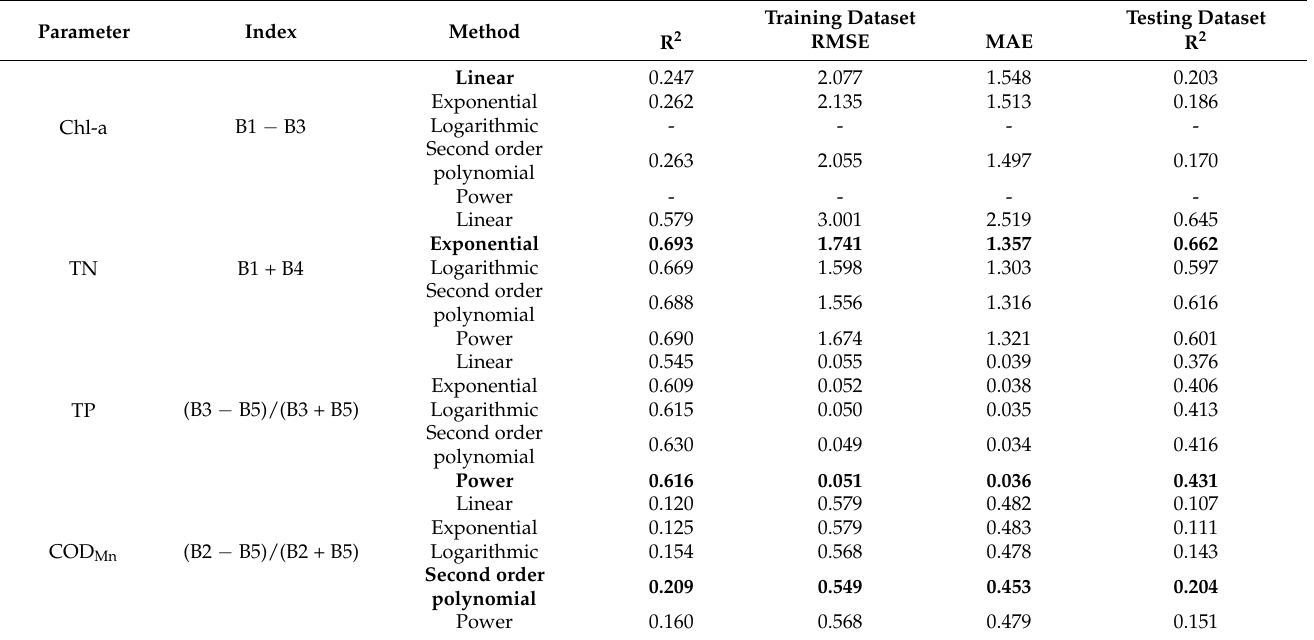
Table 5. Single-variable regression results of water quality parameters. Note: “-” represents the presence of negative values of the spectral index, and thus the logarithmic and power functions could not be fitted.